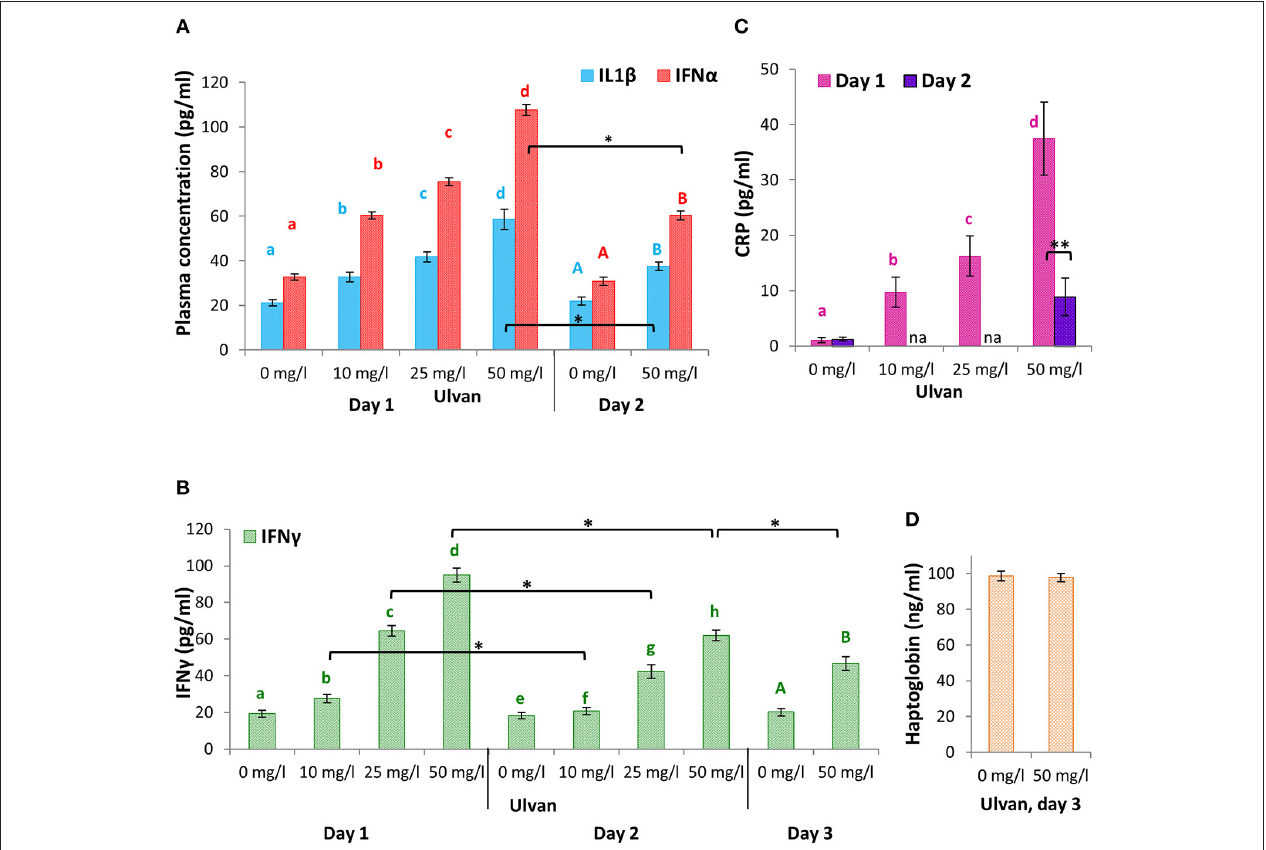
FIGURE 7 | IL1 β , IFN α , and IFN γ are released in a context of transient and moderate inflammation context. Ulvan was given per os at four different concentrations (0, 10, 25, 50 mg/l) to the animals at day 0. Blood samples (1ml per animal) were taken every day from day 0 to day 3. ELISA were performed on each plasma to quantify the concentrations of IL1 β and IFN α (A) , IFN γ (B) , C-Reactive Protein (C) , and haptoglobin (D) . Data represents the mean ± SEM of three independent experiments with 25 chickens per group. Different letters with the same color indicate statistically different values for the different doses at the same time with p < 0.05. * p < 0.05, when values are statistically different for the same dose at different